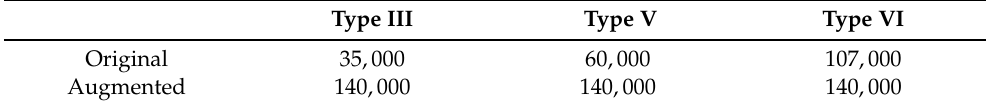
Table 2. Nodule dataset of the multiclass